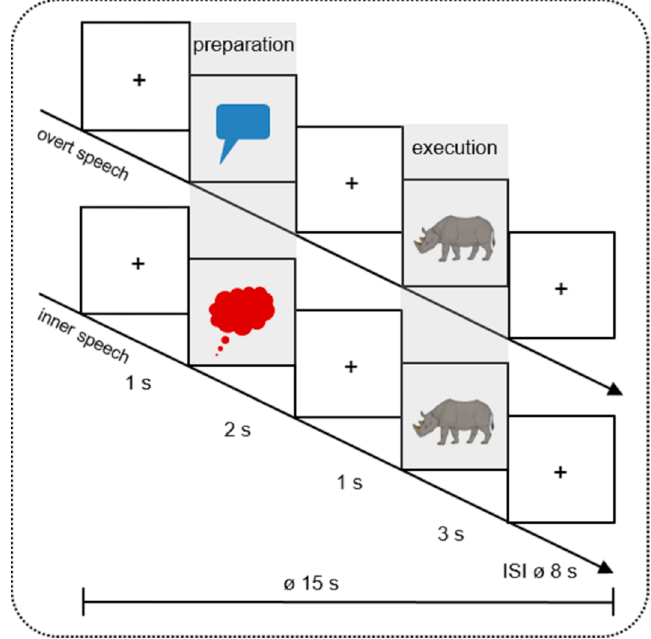
Figure 1. Design of the study . In 16 mini-blocks, 40 different colored pictures were presented twice (in inner and overt speech condition). Every mini-block contained 5 trials of the same condition. During the Preparation Phase, the pictures were cued by a red speech (overt speech condition) or a blue thinking (inner speech condition) bubble. During the Execution Phase, participants had to name the pictures (e.g., the rhinoceros) aloud or silently. The pictures were taken from Rossion and Pourtois [49] with images courtesy of the authors. + indicates a fixation cross; ø indicates the mean duration of each trial (15 s) and inter-stimulus-interval (ISI 8 s).